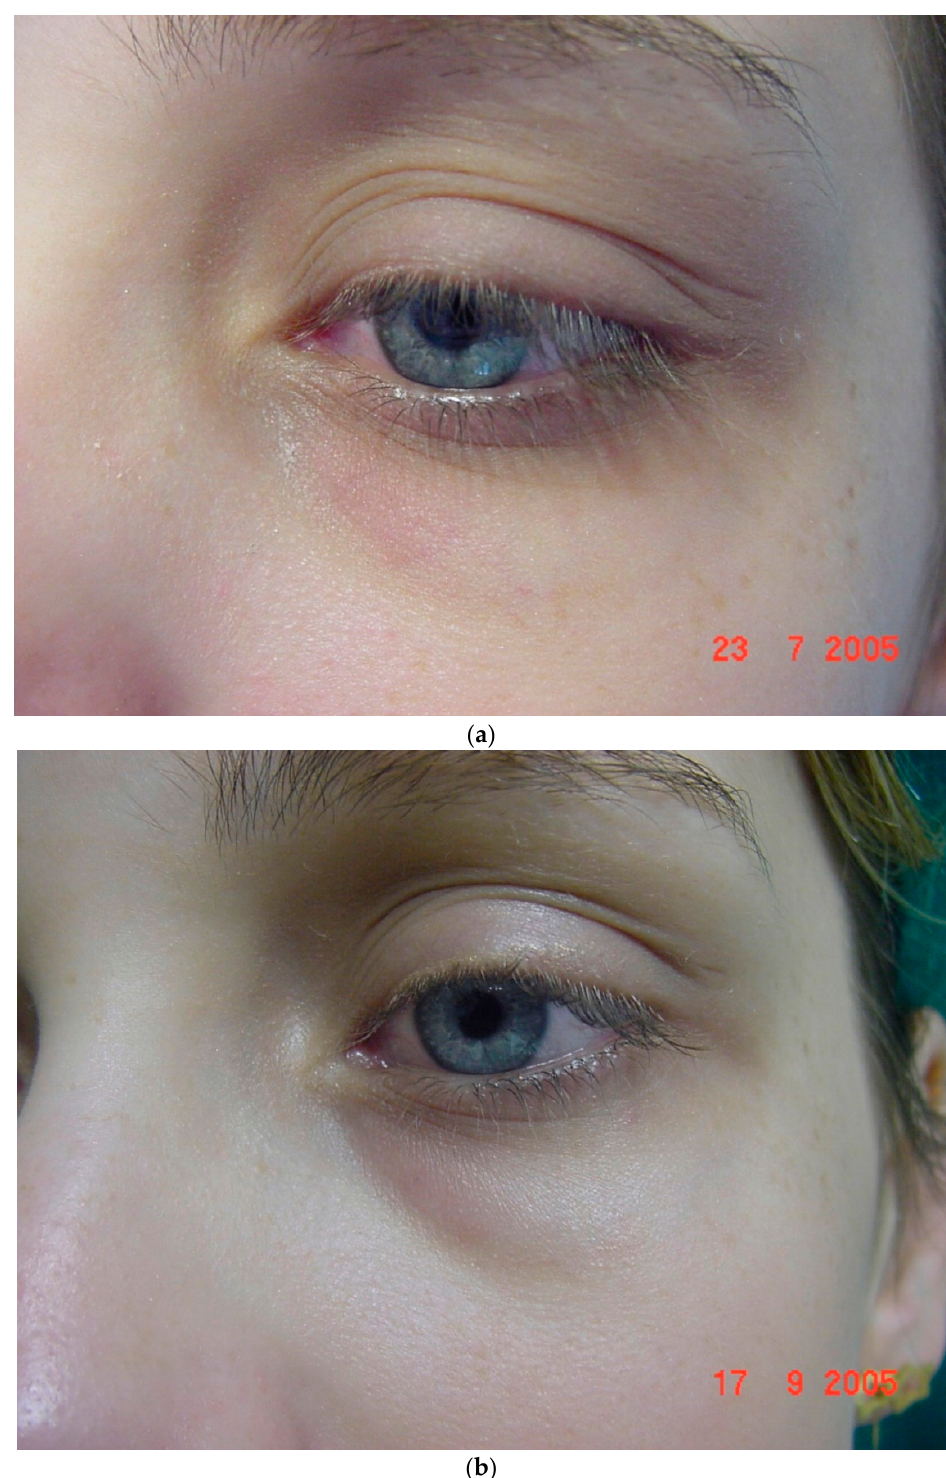
Figure 4. ( a )—Same patient as in Figure 3. ( b )—Improvement of the pigmentation, less edema and diminished show of small blood vessels after laser and IPL treatment.